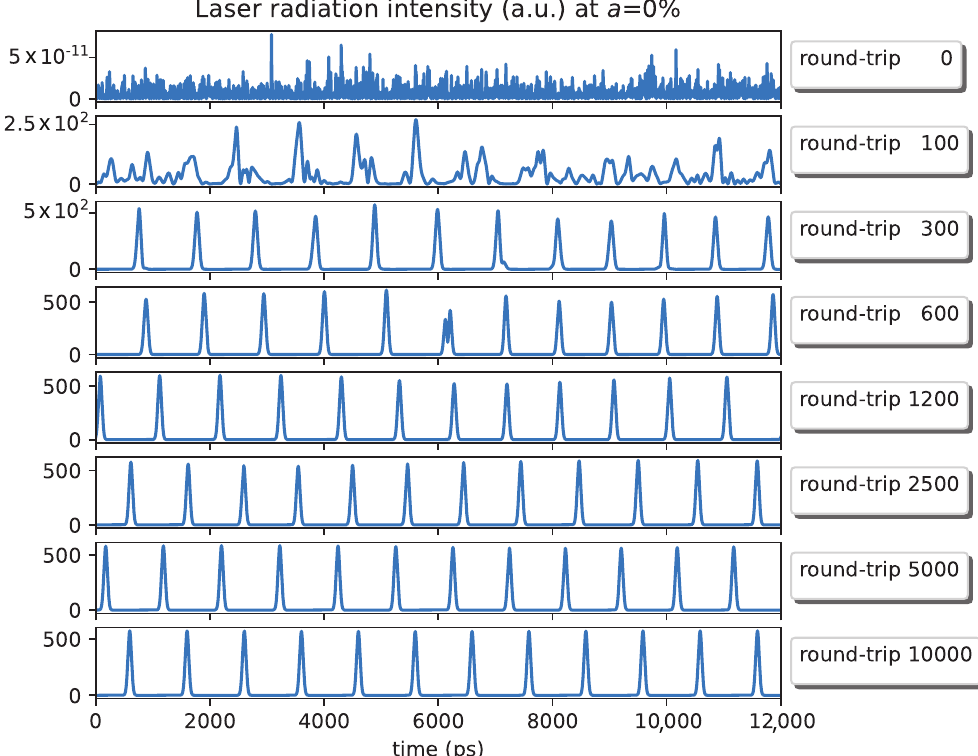
Figure 6. Laser radiation temporal fine structure calculated numerically at modulation depth a = 0%. T d = 11,330 ps. Other simulation parameters are given in Table 3.